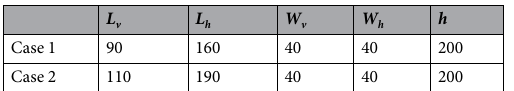
Table 1. Dimensions of the studied nanoantennas in nm.